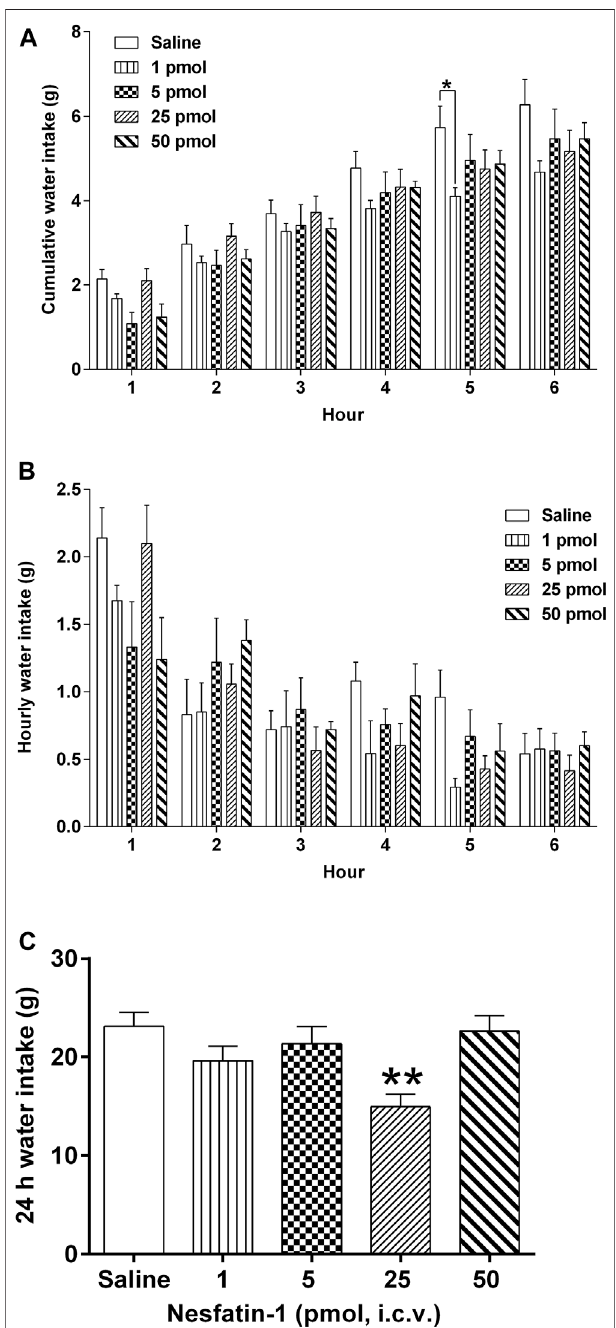
FIGURE7| Effectsofintracerebraldrugadministrationonwaterintakein Suncus murinus . (A) Cumulative water intake from 0 to 6 h, (B) hourly water intake from 0 – 6 h, and (C) cumulative water intake at 24 h after an i.c.v. administration of saline (5 μ l, i.c.v.) or nesfatin-1 (1 – 50 pmol, i.c.v). The results represent the mean ± s. e.m. of 5 – 7 determinations during a period of 24 h. Signi fi cant differences between the treatment groups are indicated as p p < 0.05 and pp p < 0.01 (one-way ANOVA or two-way ANOVA, followed by Bonferroni test).